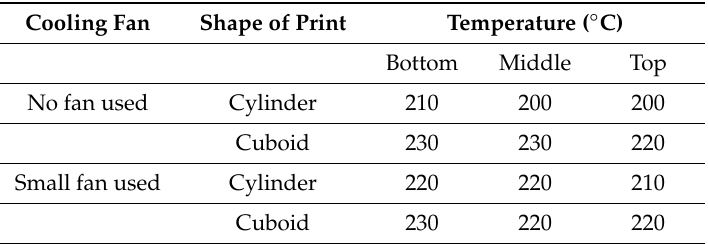
Table 2. Optimal 3D print settings for the three temperature zones of the Gigabot X for no-fan and small-fan cases for rPET flake (Figure